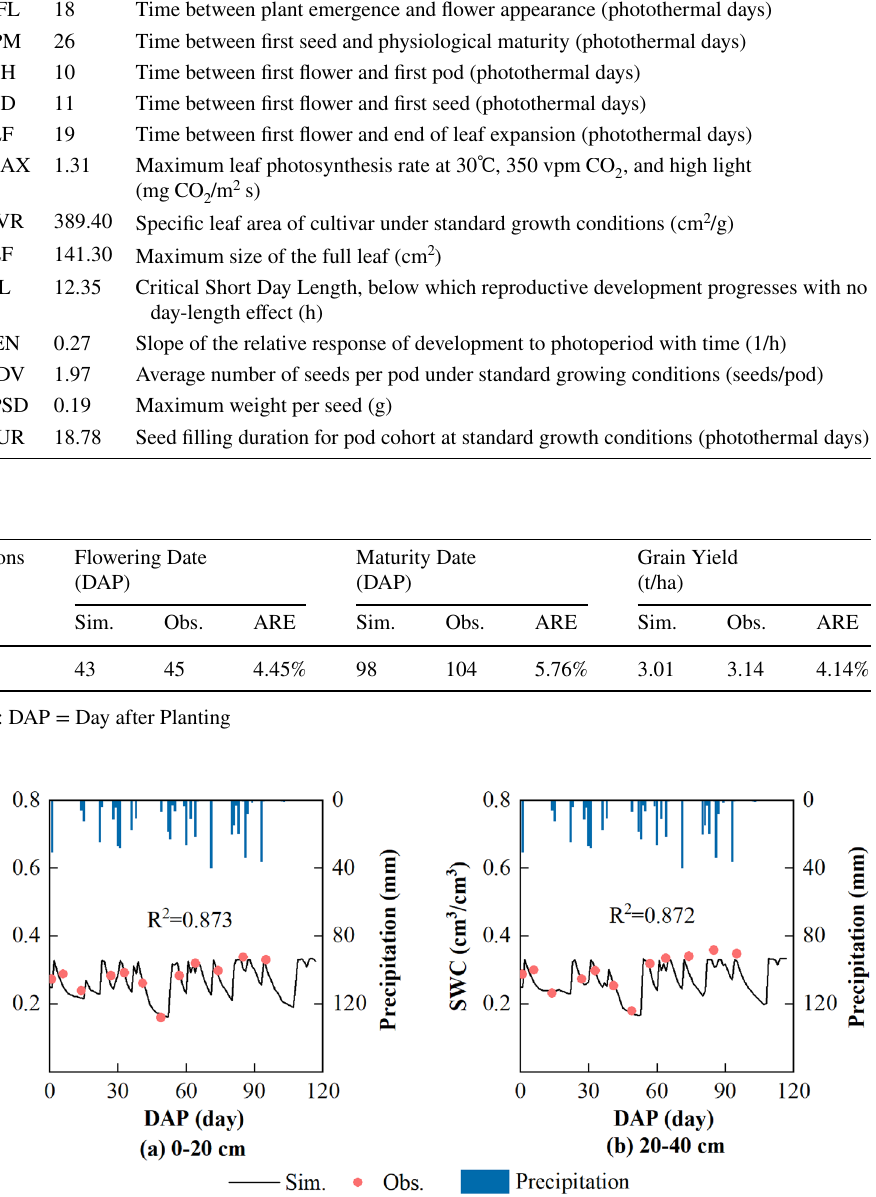
Table 6 Values of soybean cultivar specific parameters (CSPs) in the Huaibei Plain study area in Anhui Province, China